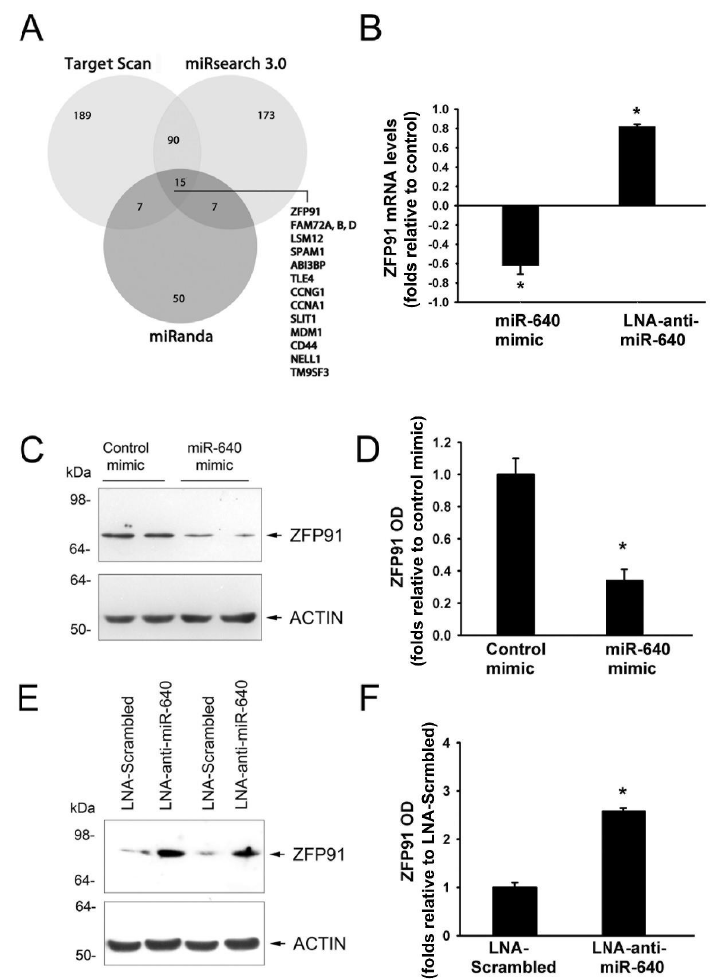
Figure 4. Identification of miR-640 targets. ( A ): Venn diagram displaying computationally predicted targets of hsa-miR-640 by TargetScan, miRanda, and miRsearch3.0. Commonly predicted targets by the three algorithms are listed. ( B ): ZFP91 mRNA expression in HUVECs transfected 48 h earlier with the control mimic, miR-640 mimic, control inhibitor, or miR-640 inhibitor. Values are means ± SEM. * p < 0.05, compared to the corresponding control group (mimic or inhibitor). ( C and D ): Representative immunoblots and optical densities (OD) of ZFP91 protein in HUVECs transfected 48 h earlier with control or miR-640 mimics. Values are means ± SEM, expressed as folds relative to the control mimic. * p < 0.05, compared to the control mimic. ( E and F ): Representative immunoblots and optical densities (OD) of the ZFP91 protein in HUVECs transfected 48 h earlier with control or miR-640 inhibitors. Values are means ± SEM and are expressed as folds relative to control inhibitor. * p < 0.05, compared to control